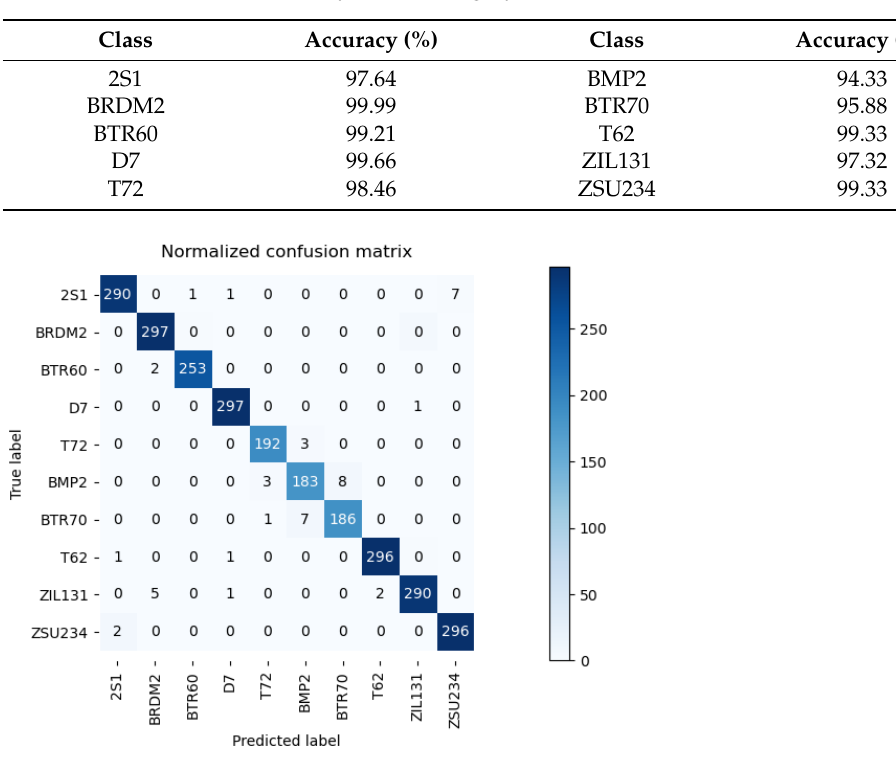
Table 2. The classification accuracy of each category in the MSTAR dataset.